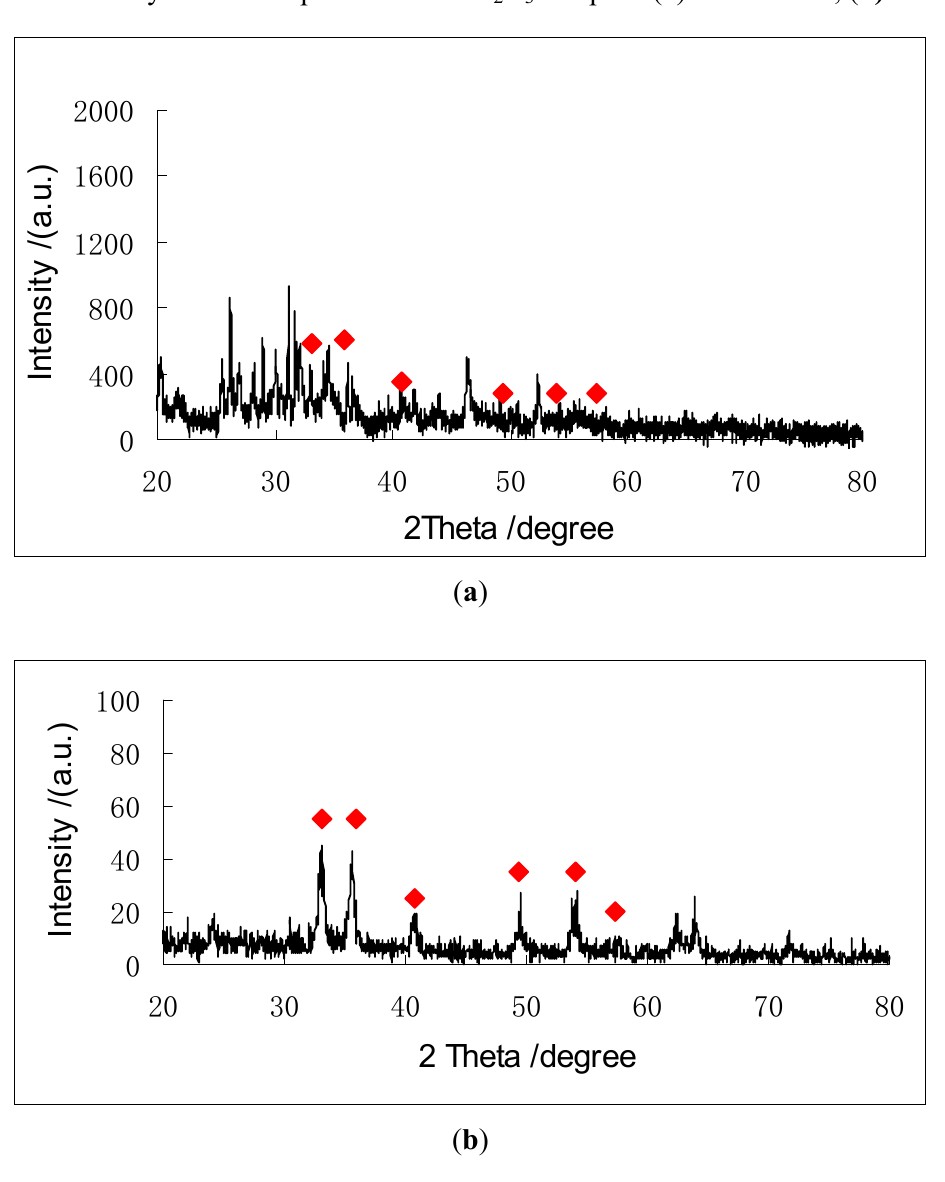
Figure 1. The X-ray diffraction pattern of the Fe